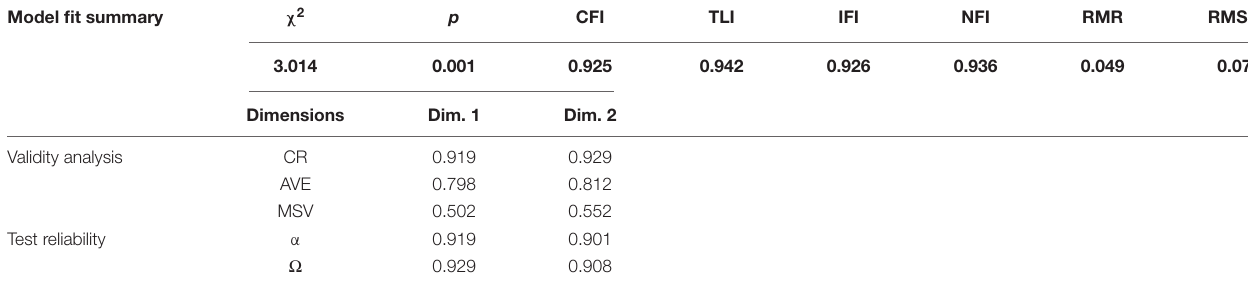
TABLE 1 | Exploratory and confirmatory factorial results and reliability of the instrument. Model fit